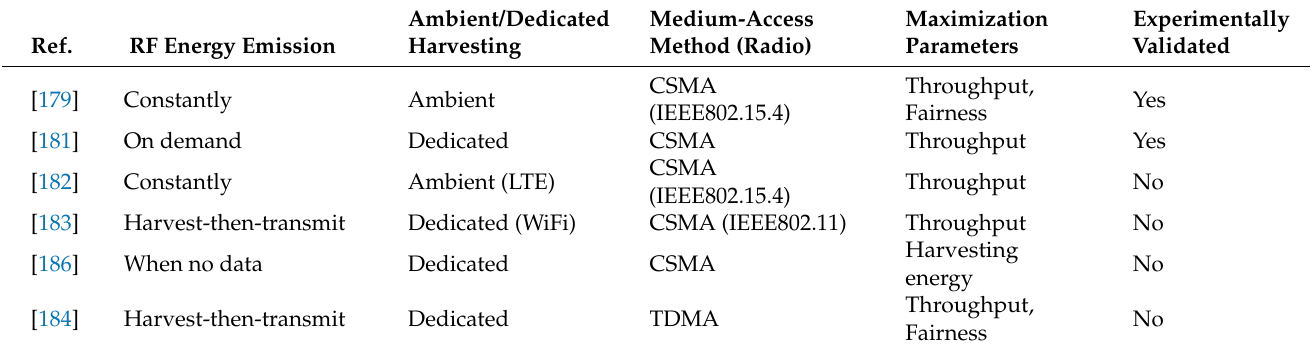
Table 8. Characteristics and features of the proposed RF power harvesting enabled MAC